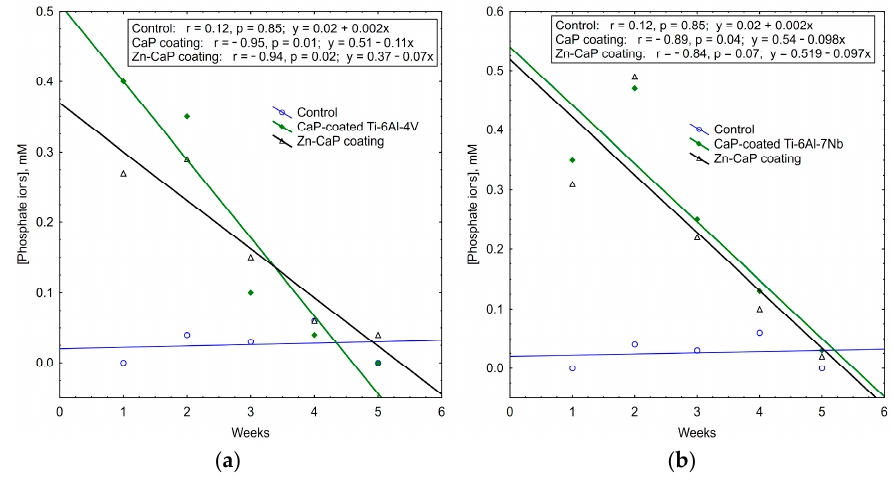
Figure 11. Regression lines of median phosphate ion concentrations in weekly extracts during 5-week immersion of ( a ) Ti–6Al–4V and ( b ) Ti–6Al–7Nb substrates with different CaP coatings in 0.9% NaCl solution.